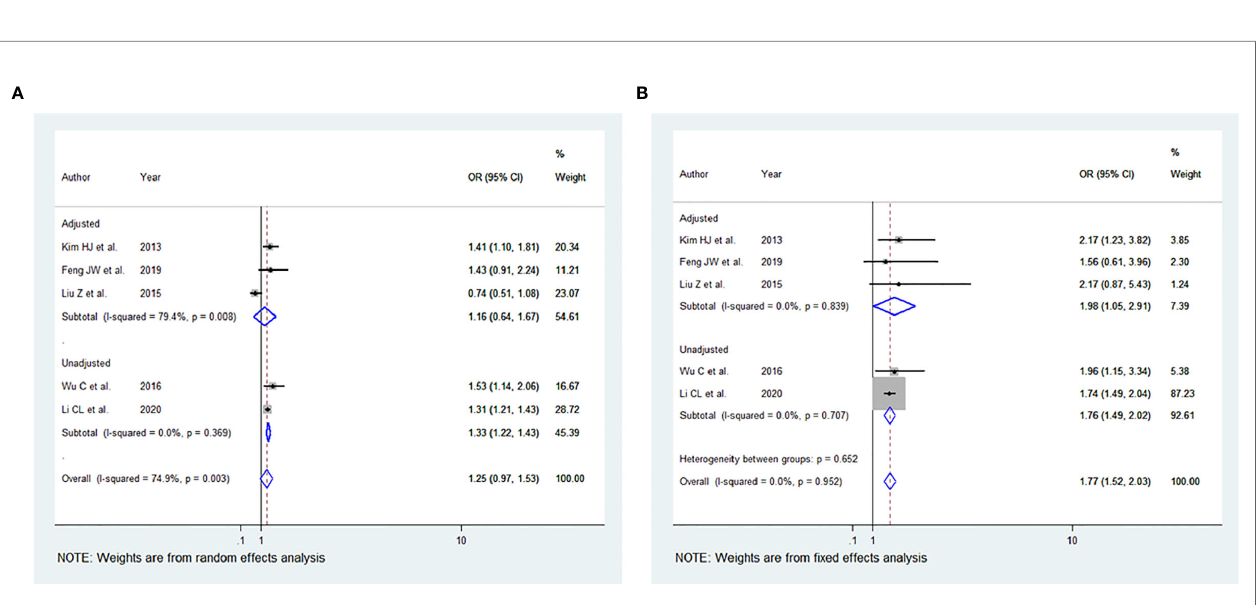
FIGURE 3 | Forest plots for the meta-analysis for the association between Body Mass Index and Tumour -Size. (A) Meta-analysis between overweight and tumour size. (B) Meta-analysis between obesity and tumour